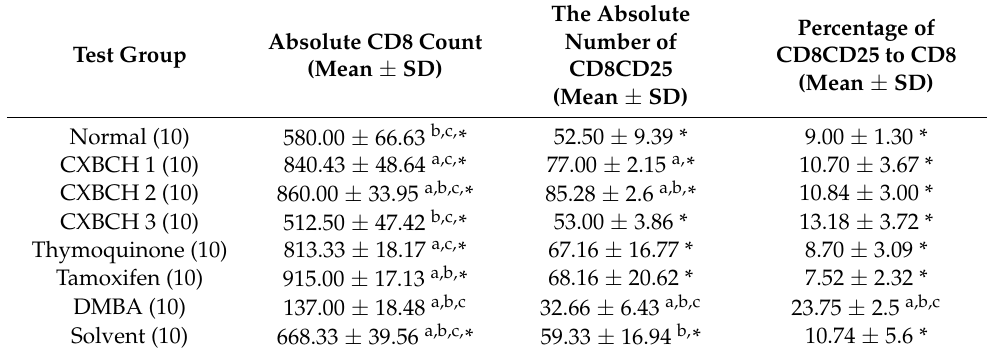
Table 9. The absolute number of peripheral blood CD8 lymphocytes of SD rats induced with DMBA at 2 × 20 mg/kgBW/week for five weeks after receiving CXBCH treatment for seven weeks. Blood sampling was carried out at the 30th week of the